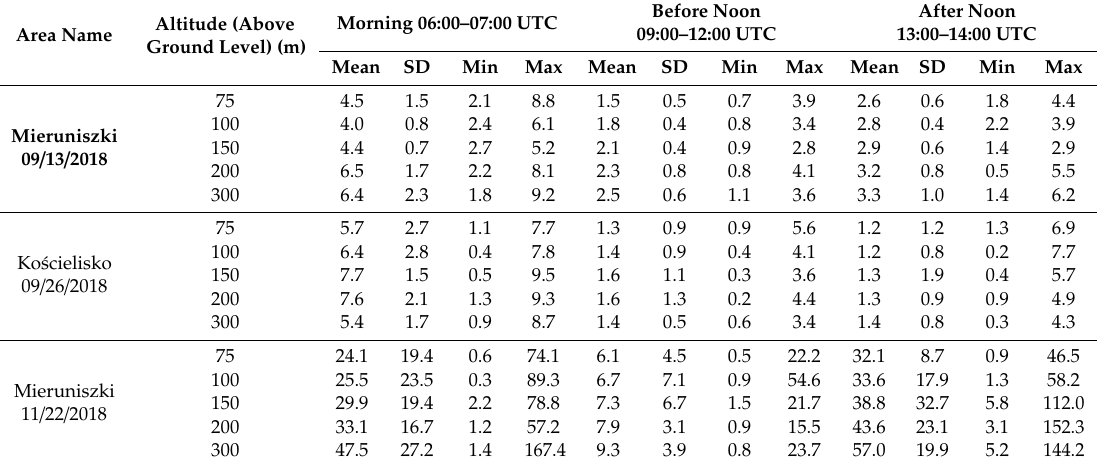
Table 4. Q A indicator statistics for the verification sets of UAV imagery